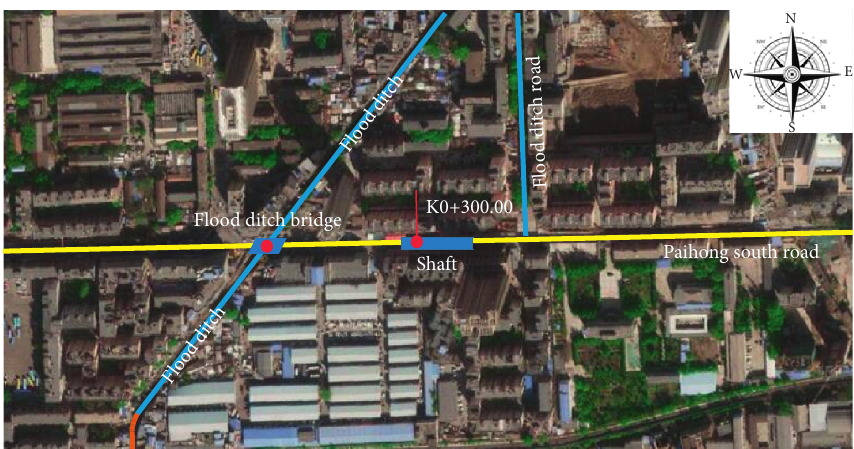
Figure 1: Schematic layout of entry-exit line marking section.